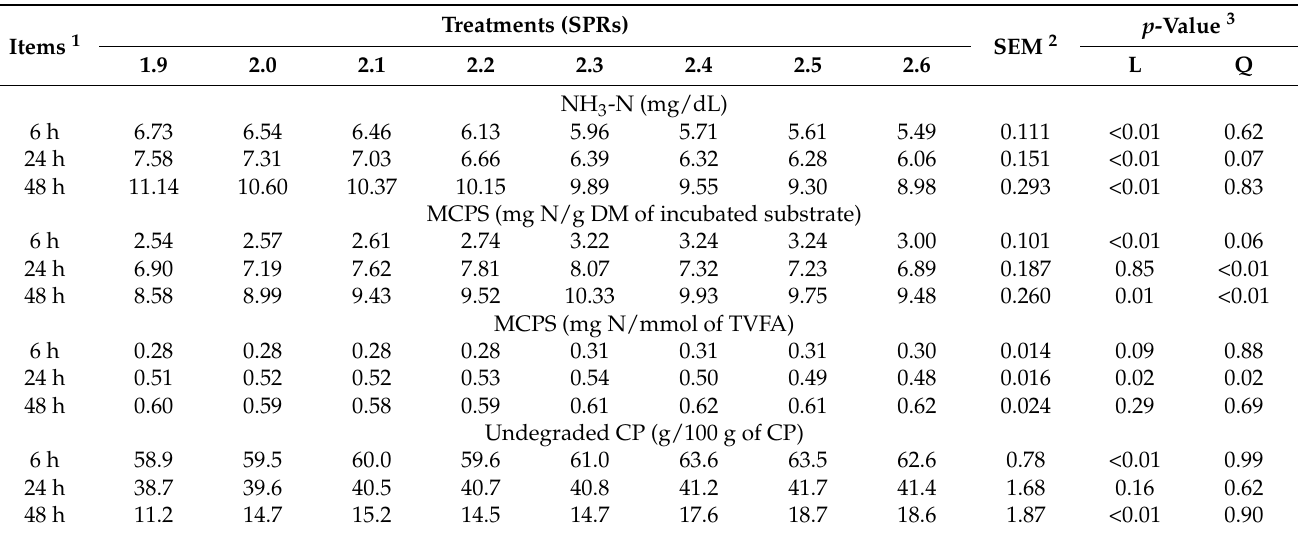
Table 4. Effects of dietary rumen-degradable starch to rumen-degradable protein ratio (SPR) on the concentration of ammonia nitrogen (NH 3 -N), microbial protein synthesis (MCPS), and undegraded crude protein (CP) at different in vitro incubation times.